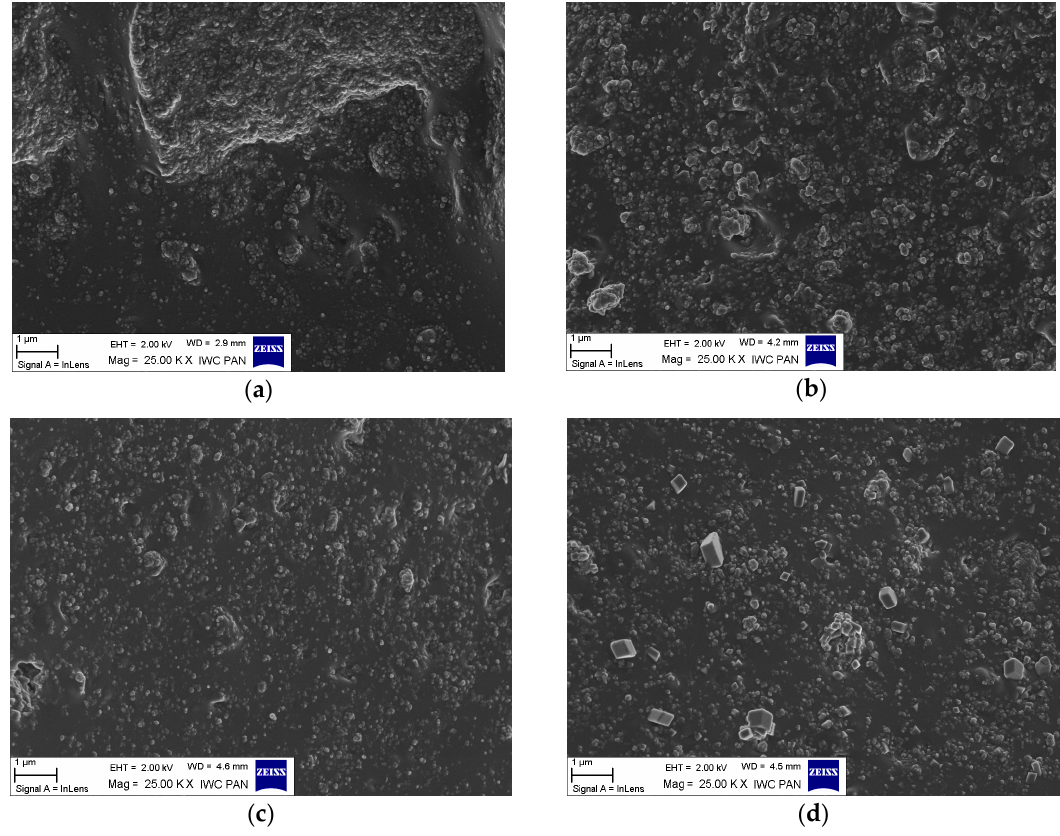
Figure 5. Scanning electron microscopy (SEM) images for silica-filled ethylene–propylene copolymer (EPM) vulcanizates with ( a ) CaO / ALA, ( b ) CaO / ALA and BmimCl, ( c ) CaO / ALA and BmimBF 4 , and ( d ) CaO / ALA and BmimPF 6 .